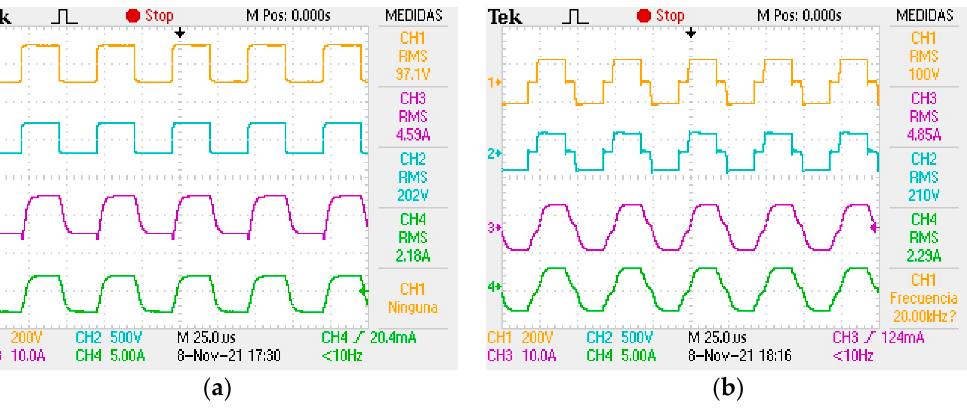
Figure 10. AC signals in the MFT : ( a ) 2L and ( b ) 3L.